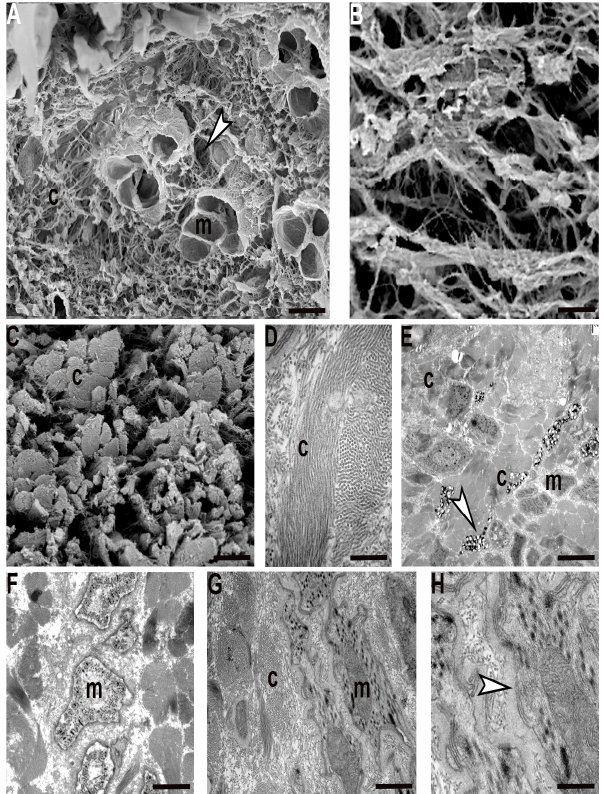
Figure 4. Recently hatched H. verbana , in cross section. Scanning (SEM) and Transmission (TEM) electron microscopy. SEM ( A – C ) and TEM ( D – H ) analysis of cross sectioned leech. The ECM, and in particular collagens (c), are predominant in respect to the myocytes (m). The muscle fibres, very few and small in size (m), are embedded in the ECM with loose properties (white arrowhead) ( A ). Different spatial and structural organization of collagen in the formation of scaffold, that can be loose ( B ) or stiff due to the presence of collagenic bundles (c), is visible ( C ). ( D – H ) TEM micrographs. Thick collagenic bundles (c) ( D ), and loose ECM radially alternated, identify corridors ( E – G ) occupied by immunocytes (white arrowhead, ( E )) and myocytes (m, ( E , F )) with ruffled profiles ( F , G ). Detail of migrating myocyte showing a thick basal membrane (white arrowhead, ( H )). Scale bars: ( A , C ) 4.3 µ m; ( B , E ) 2.5 µ m; ( G ) 2 µ m; ( F ) 1.7 µ m; ( H ) 500 nm; ( D ) 400